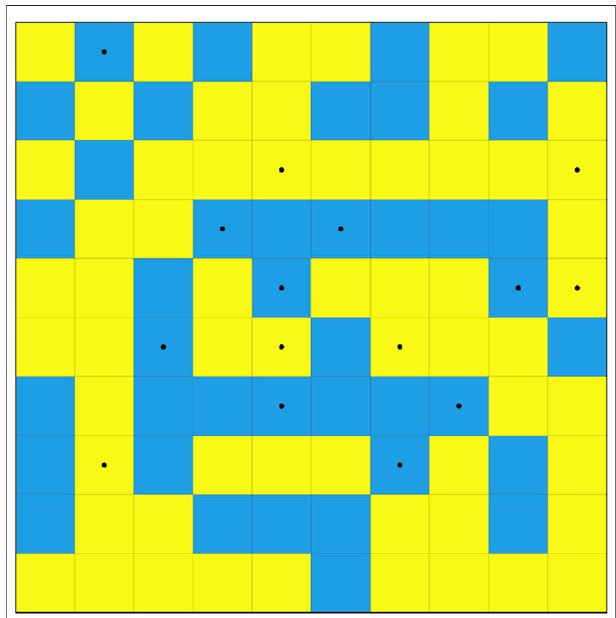
FIGURE 9 | Positive (yellow) and negative (blue) frequency variations between the future time slice 2081-2100 under RCP8.5 scenario and historical climate from the ensemble of the regional climate simulations. Black dots stand for change consistency.